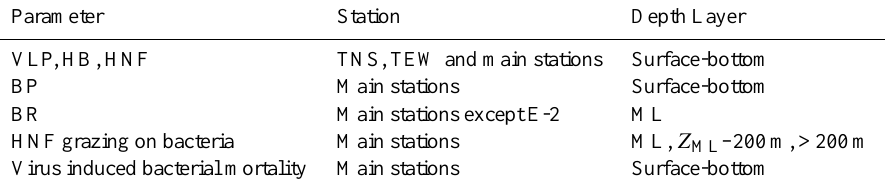
Table 1. Overview of the parameters determined in the present study. VLPs: virus-like particles; HB: heterotrophic bacteria; HNF: het- erotrophic nanoflagellates; BP: bacterial heterotrophic production; BR: bacterial respiration; TNS: north–south transect; TEW: east–west transect; main stations: R-2, A3, E-4W, F-L, E-1, E-2, E-3, E-5, E-4E;ML: mixed layer; Z ML : depth of the mixed layer.